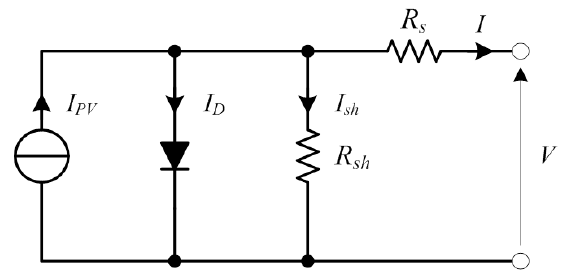
Figure 4. Diagram of the simulated off grid PV